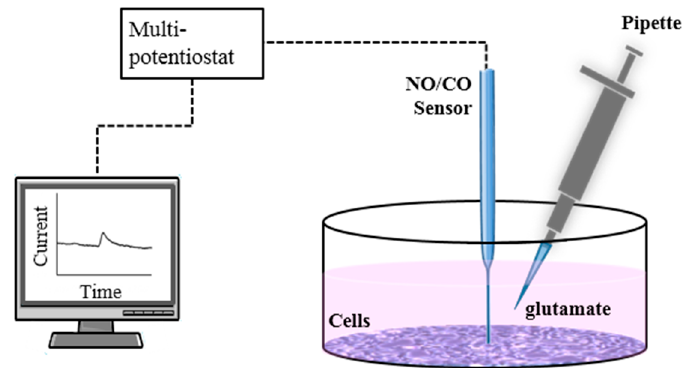
Figure 1. The experimental setup for real-time NO and CO measurements for functional human neuroblastoma cells with a glutamate injection. A vertical distance between the end plane of a sensor and cell monolayer surface is approximately 10 µm. NO/CO sensor in this figure represent either dual or septuple sensors.